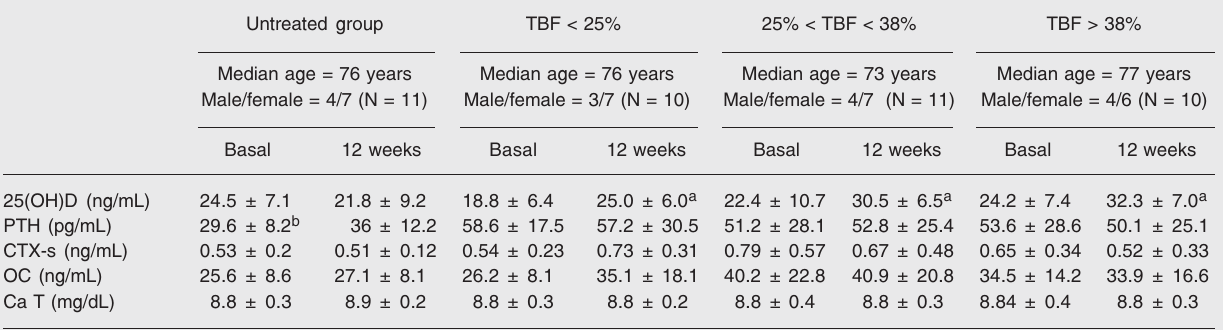
Table 1. Basal and 12-week levels of 25(OH)D, PTH, CTX-s, OC, and total calcium in the untreated group and in the groups treated with cholecalciferol, 7000 IU/week, and divided into groups according to body fat percentage. Untreated